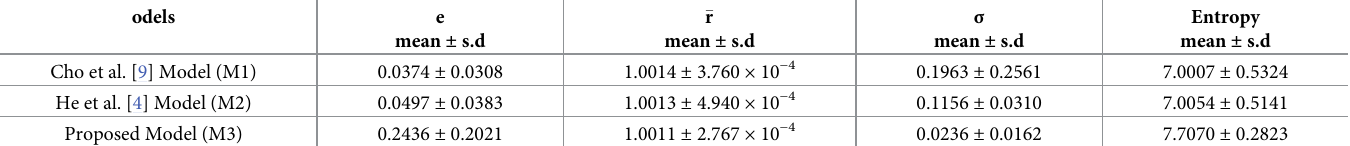
Table 4. Quantitative outputs under coefficients (e, � r , σ ) and entropy measure for the de-hazed images of Figs 5 to 16.